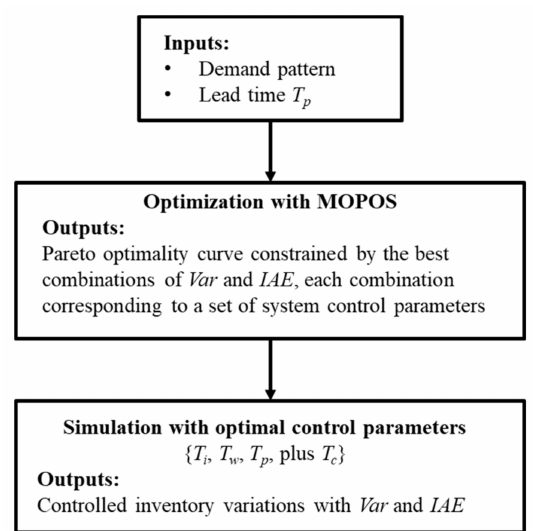
Figure 3. The process of dynamic simulation of a production–inventory